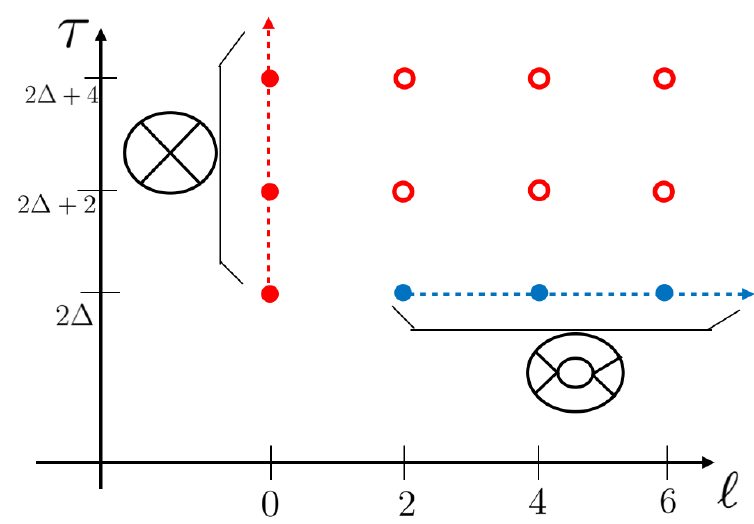
Figure 5: The functional Λ τ given in (77), and its contribution to the sum , (cid:96) , m rule (78). The red dots signify double zeros of the functional, Λ τ , and the blue , (cid:96) , m dots signify single zeros of the functional. At subleading order, the sum rule (78) receives two types of contributions. A contribution at (cid:96) = 0 and n = 0,1,2,... com- ing from contact diagrams in AdS. And a contribution from the leading tracjectory τ = 2 ∆ and (cid:96) = 2,4,6,... coming from the 1-loop bubble diagrams in